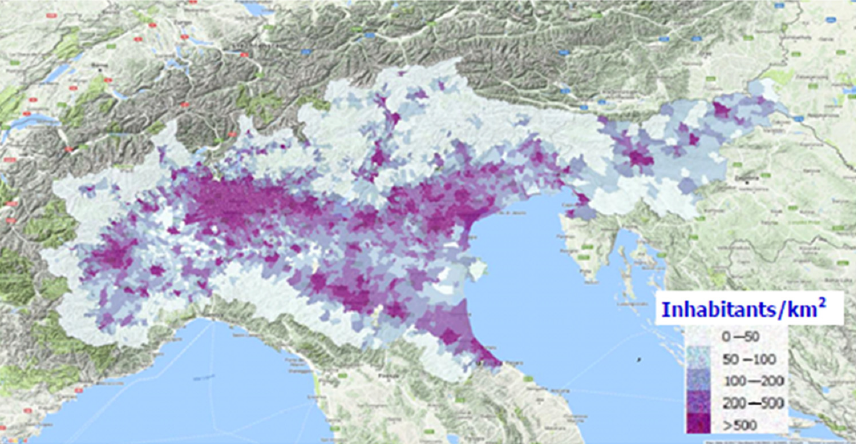
Figure 1. Po Regions Engaged to Policies of Air (PREPAIR)project target area.